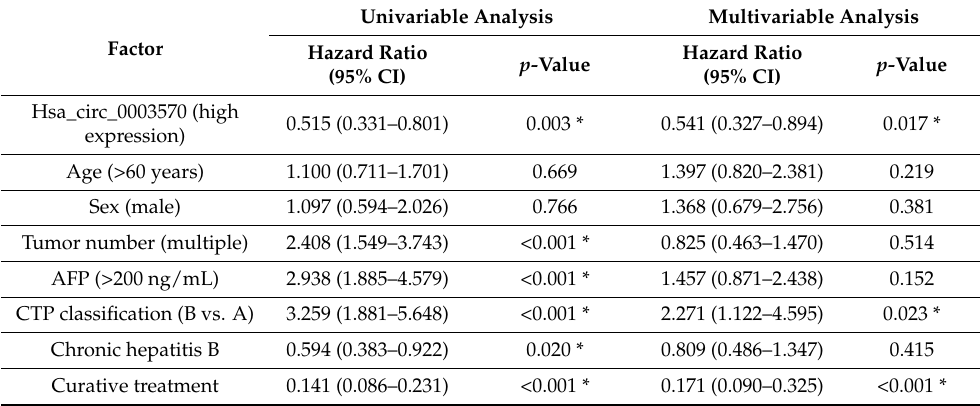
Table 3. Prognostic factors for overall survival in univariable and multivariable